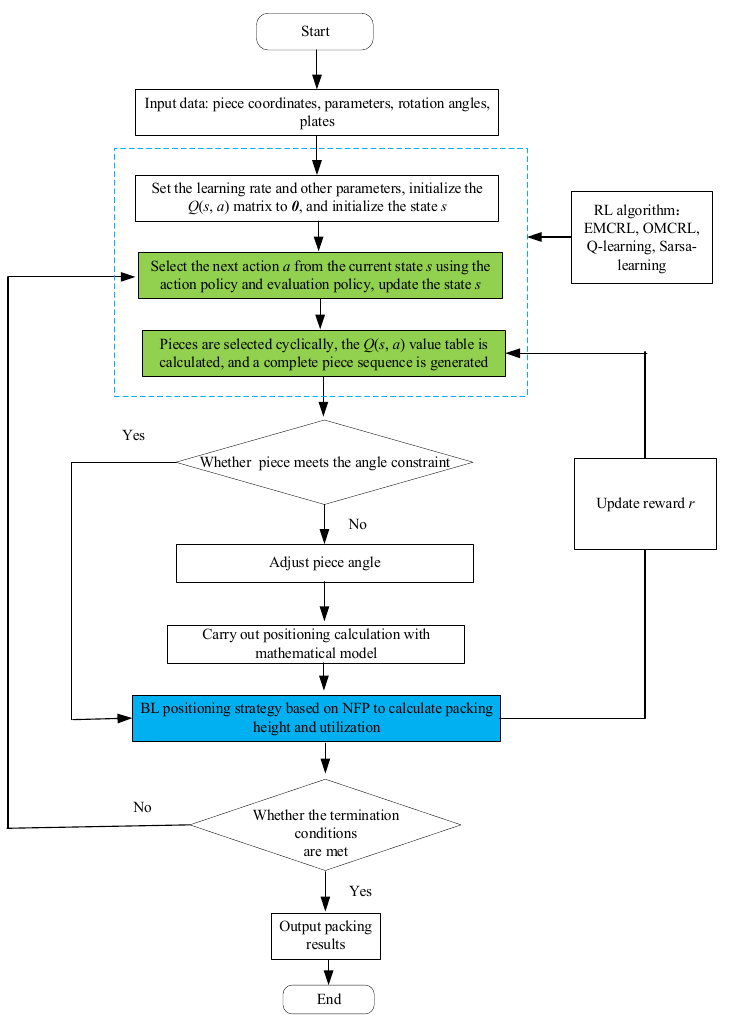
Figure 7. The process of the hybrid RL algorithm for 2D irregular-piece packing. Algorithm 2 Q-learning for a 2D irregular packing problem